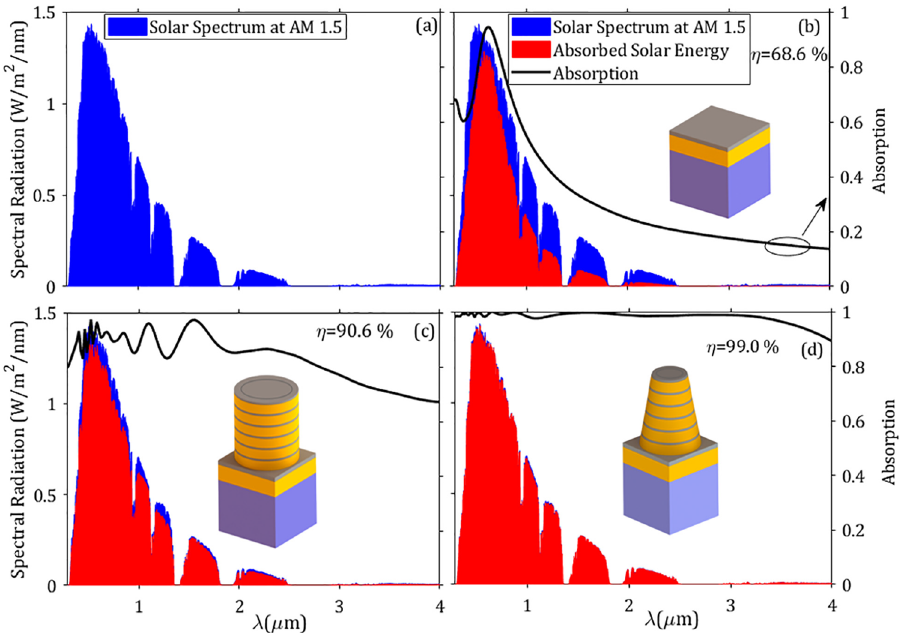
Figure 9. Absorption of the proposed metasurface under a solar spectrum at AM1.5. ( a ) solar radiation at AM1.5. ( b – d ) are the absorbed energy of the planar structure, metasurface with cylindrical elements, and metasurface with truncated cones of α = 76.78 ◦ , respectively.